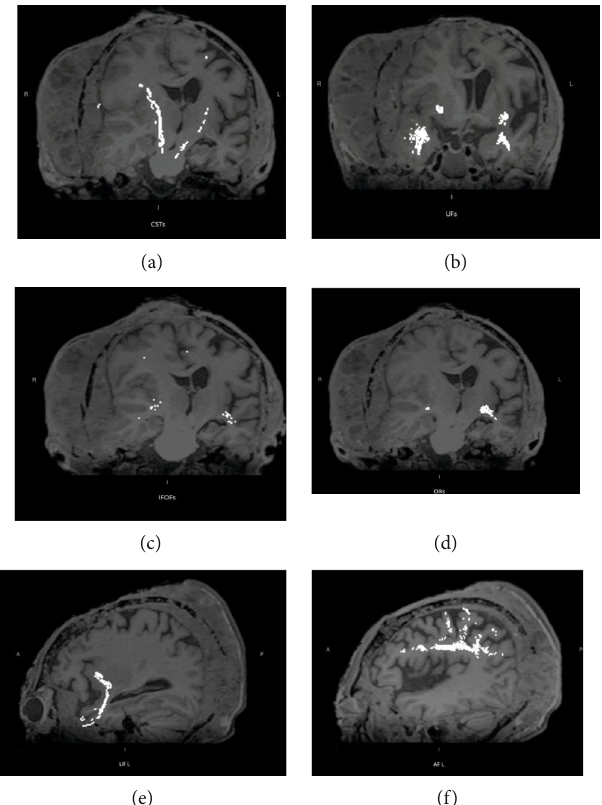
Figure 3: High-resolution tractography shows signi fi cant leftward deviation of the right white matter tracts, mainly of (a) corticospinal tract and (b) uncinate fasciculus, with rarefaction of fi bers of the (c) right inferior fronto-occipital fasciculus and (d) optic radiation. On a sagittal plane, the (e) left optic radiation and (f) arcuate fasciculus appear fully